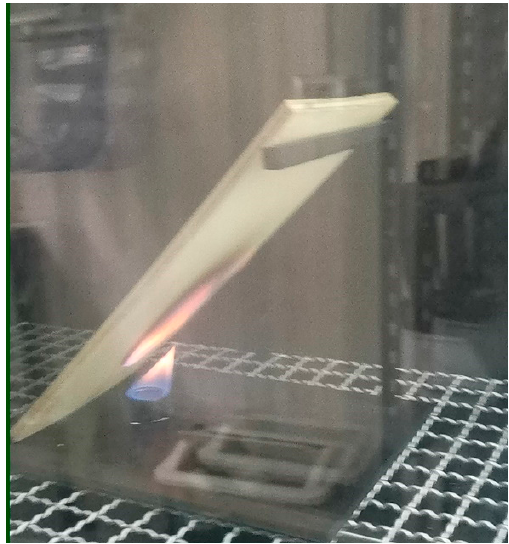
Figure 1. Fire resistance test according to the Chilean Standard NCh1974. The samples are ignited inside a 400 mm × 700 mm × 810 mm cabinet under a constant air flux (0.2 m·s − 1 ). Blurriness of the image due to the template glass cover on the front of the cabinet.